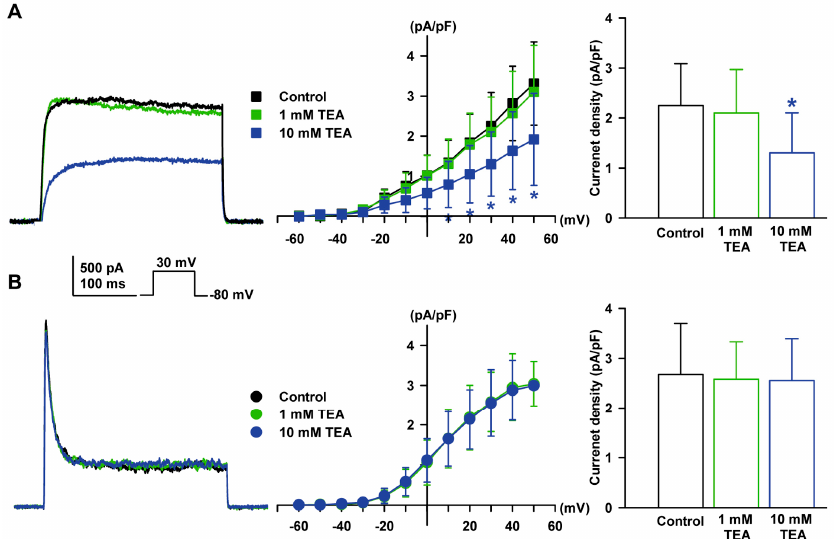
Figure 3. Effect of tetraethylammonium chloride (TEA) on K V currents in HCFs. ( A ) The representative I K recorded in a single HCF in control conditions and after application of TEA (1 or 10 mM) are shown. The I-V relationship of the steady-state current change of I K by TEA and bar graphs for concentration change are also shown. ( B ) The typical I to was not changed by TEA. The I-V relationship of the peak current change for the TEA of I to and bar graph for concentration response are shown. * p < 0.05 versus the control.